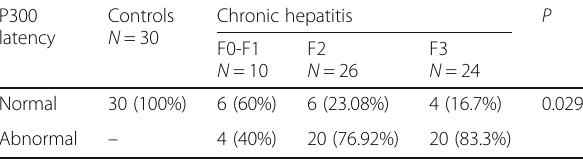
Table 4 Frequency of abnormal P300 peak-evoked potential latency between HCV patients and control